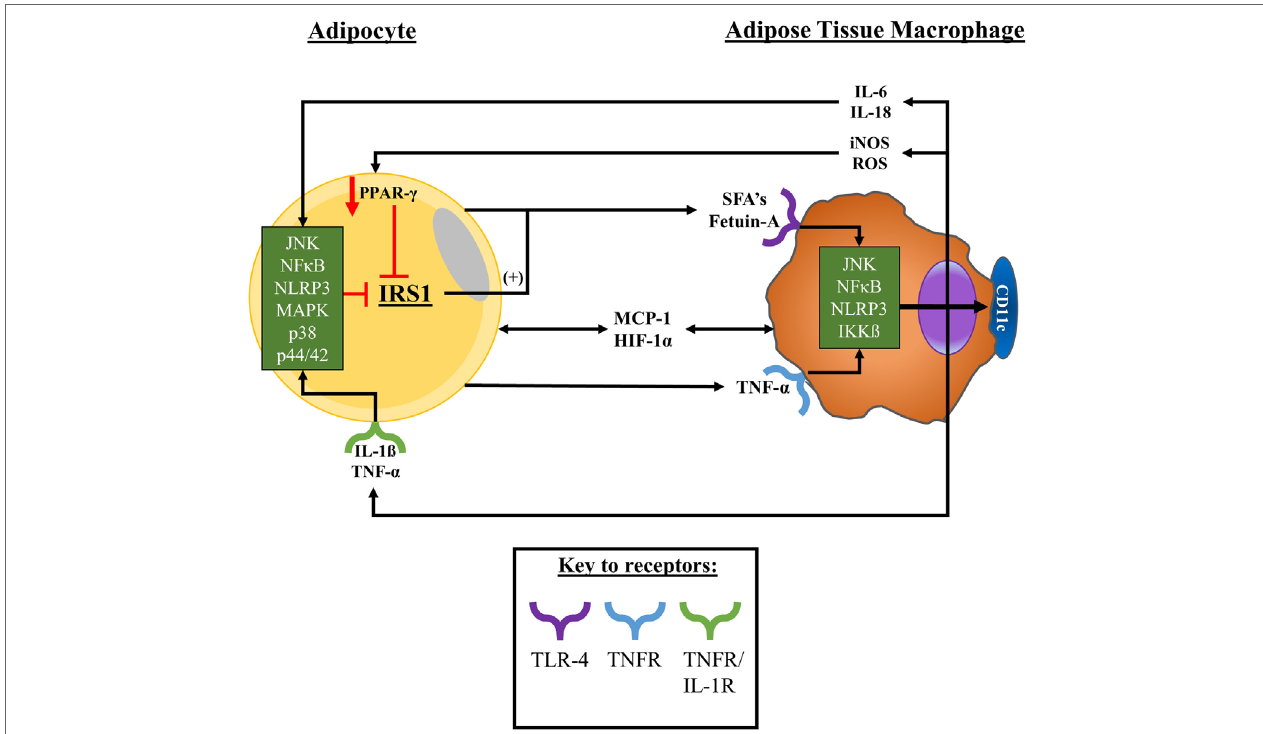
FiGURe 2 | Adipocyte–macrophage interactions with obesity. With obesity, adipocytes expand promoting a state of proinflammation, ER stress, and tissue hypoxia, promoting adipocyte apoptosis/necrosis. Upon these changes in obese adipose tissue macrophages are signalled into the tissue by hypoxic, chemokine, and cytokine signals to surround dysfunctional adipocytes. Macrophages in obese adipose tissue release, and are exposed to, TNF- α and MCP-1—among other factors, including SFAs—which collectively promote the activation of a variety of stress signalling cascades. Consequently, adipose-resident macrophages adopt a pro-inflammatory secretory profile and upregulate their surface expression of CD11c. As a result, adipocytes become exposed to secreted factors such as TNF- α and MCP-1, exacerbating the pro-inflammatory microenvironment of the tissue and potentiating the activation of stress signal cascades within adipocytes. These interactions promote a feed-forward recruitment of monocytes into the tissue and their pro-inflammatory polarisation as well as impairing tissue insulin sensitivity that potentially promotes the release of FFAs into the microenvironment. Abbreviations: CD, cluster of differentiation; ER, endoplasmic reticulum; FFAs, free-fatty acids; HIF-1 α , hypoxia-inducible factor-1 α ; IKK β , inhibitor of nuclear factor kappa B kinase subunit beta; IL, interleukin; IL-1R, interleukin-1 receptor; iNOS, inducible nitric oxide synthase; IRS-1, insulin receptor substrate 1; JNK, c-Jun N -terminal kinases; MAPK, mitogen-activated protein kinase; MCP-1, monocyte chemoattractant protein 1; NF κ B, nuclear factor kappa B; NLRP-3, NLR family pyrin domain containing 3; PPAR- γ , peroxisome proliferator-activated receptor gamma; ROS, reactive oxygen species; SFAs, saturated fatty acids; TNFR, tumour necrosis factor receptor; TNF- α , tumour necrosis factor- α